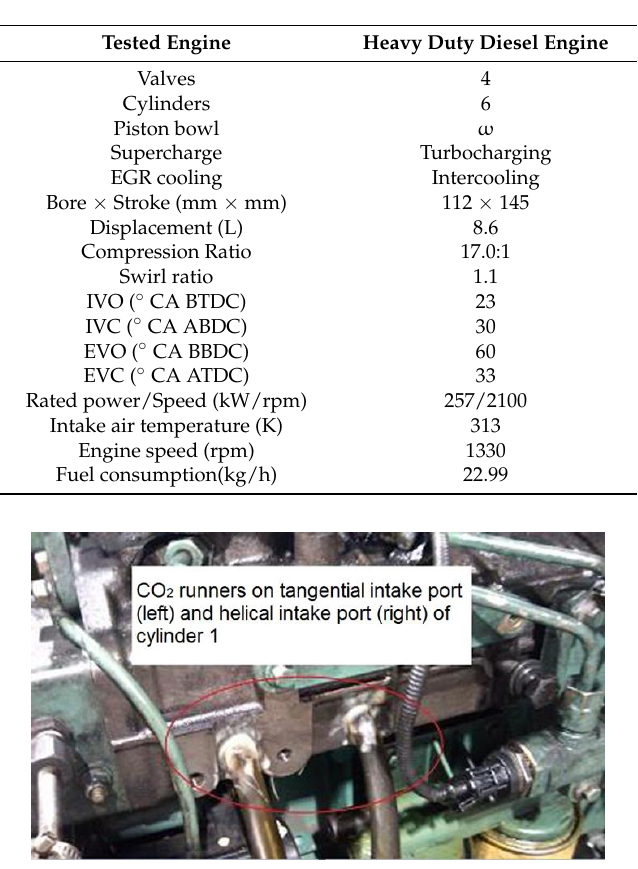
Table 1. Engine specifications.